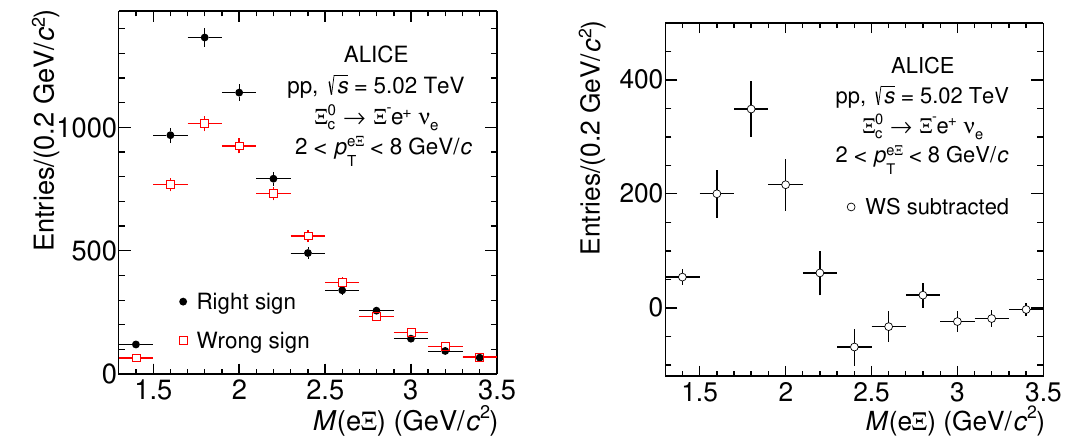
Figure 2 . Left panel: invariant mass distributions of right-sign and wrong-sign eΞ pairs with 2 < p T < 8 GeV/ c . Right panel: invariant mass distribution of Ξ 0 the wrong-sign pair yield from the right-sign pair